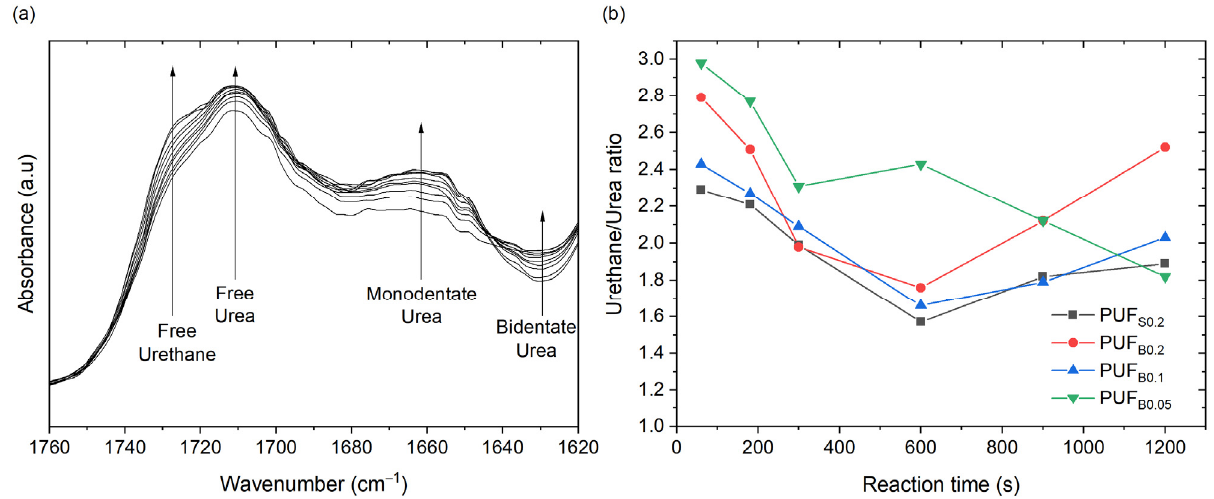
Figure 4. ( a ) Infrared spectra collected at the initial stages of the reaction in the carbonyl region for PUF B0.2 sample; ( b ) urethane/urea ratios as a function of time.